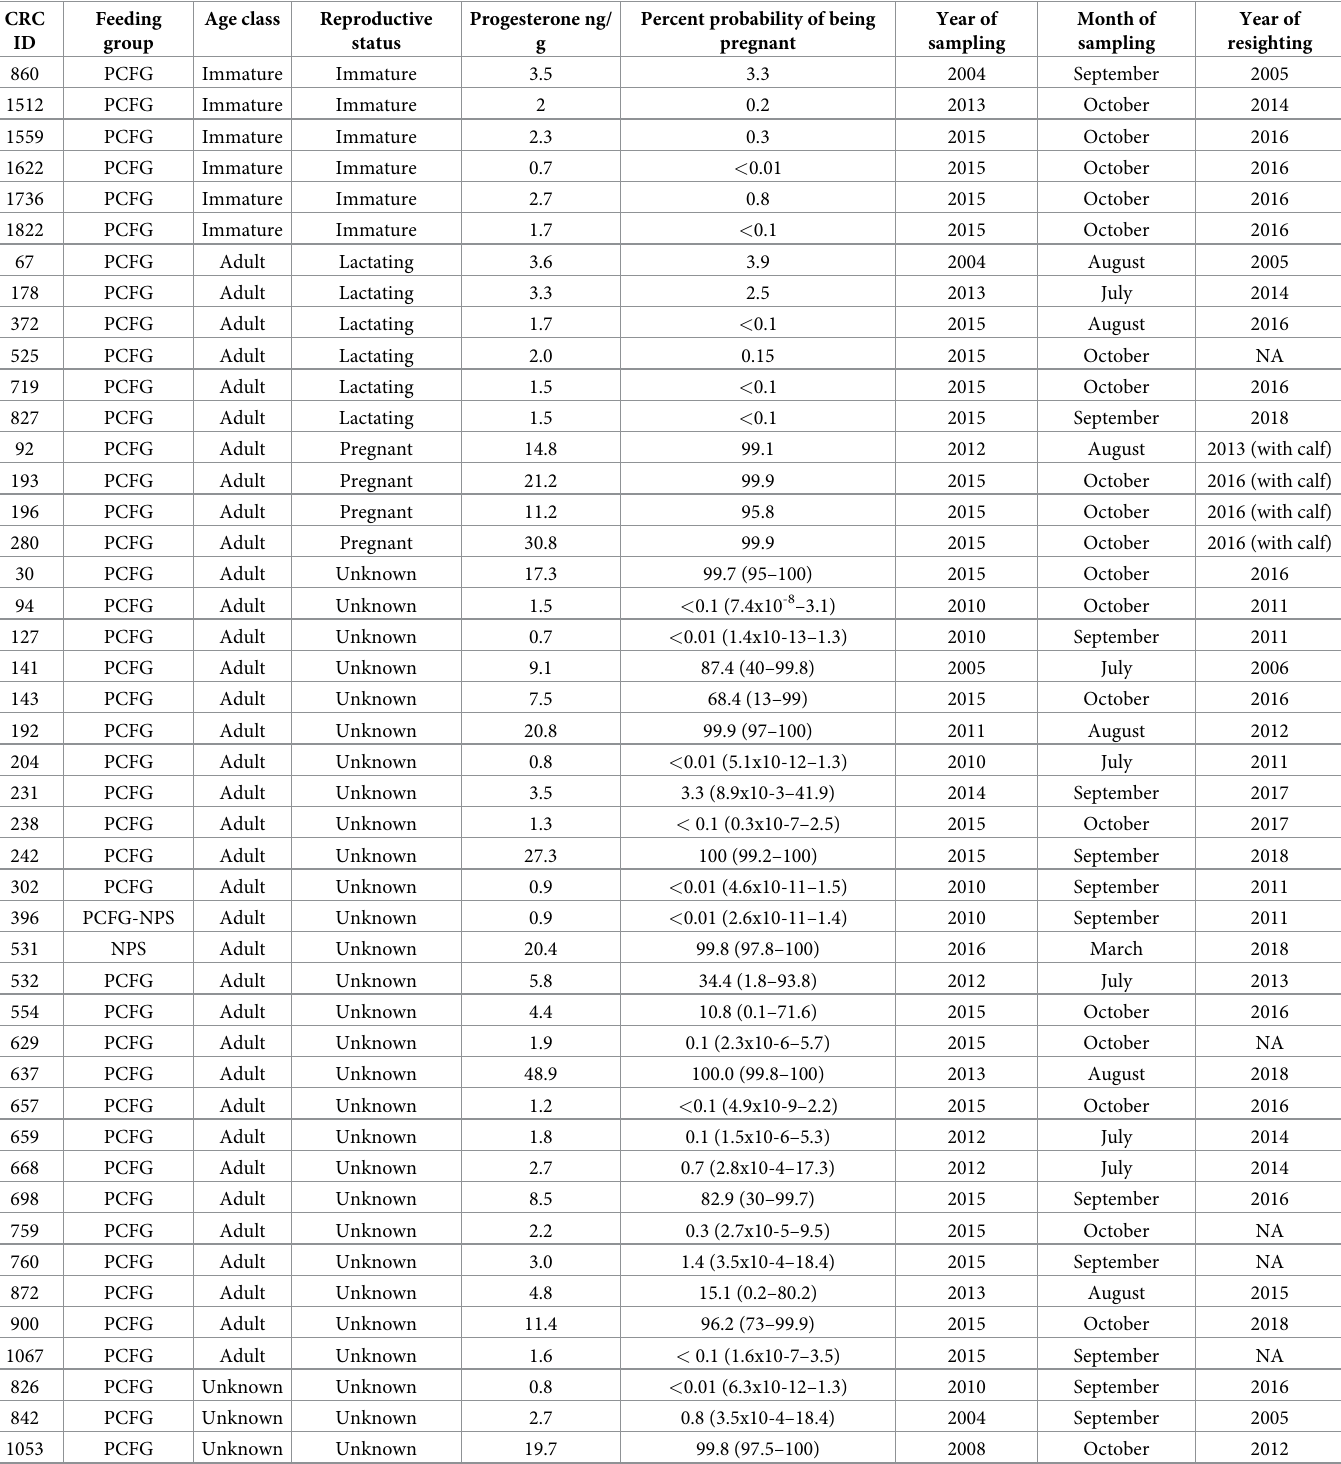
Table 4. Percent probability of being pregnant assigned to each female gray whale of known and unknown reproductive status. For each whale the probability was calculated based on the progesterone concentration (ng/g), using the two distributions identified via mixture model. Additional information included is feeding group, age class, the year and month of sampling and the year of subsequent sighting including whether with a